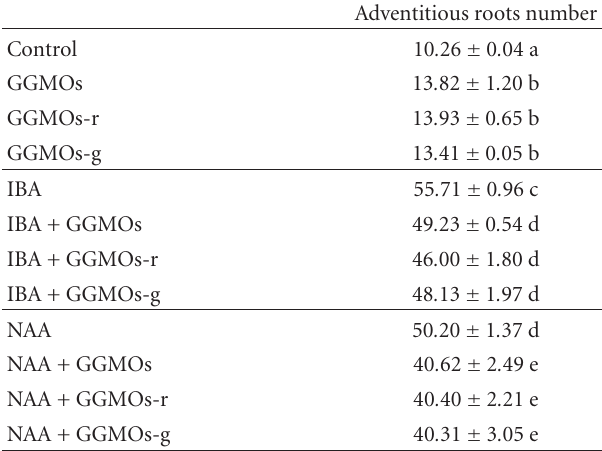
Table 1: E ff ect of GGMOs, GGMOs-g, and GGMOs-r alone, and in combination with IBA or NAA on mung bean adventitious root formation. Control—without any plant growth regulators. Means followed by the same letters are not significantly di ff erent at P < 0 . 05 according to LSD